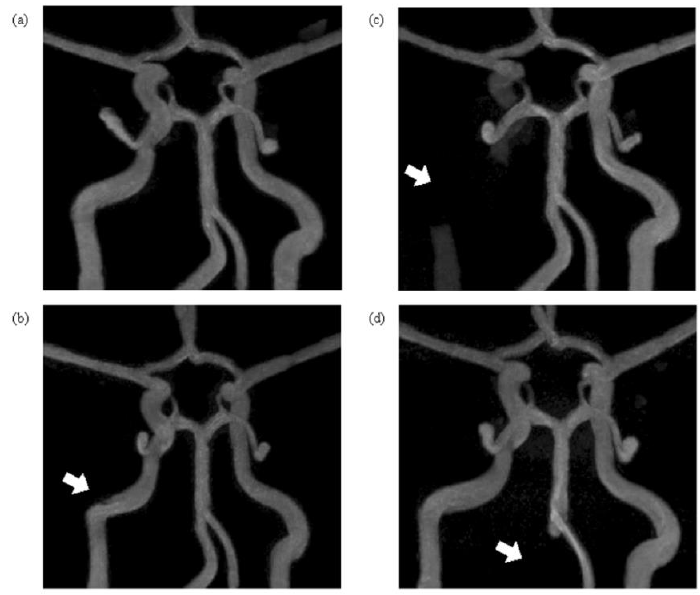
Figure 4. Time-of-flight (TOF) MRA maximum intensity projection (MIP) images of each vascular model: ( a ) normal phantom; ( b ) right ICA 50% stenosis phantom (ICA50); ( c ) right ICA 100% occlusion phantom (ICA100); and ( d ) right vertebral artery (VA) 100% occlusion phantom (VA100). The reconstructed TOF MRA images from each phantom were visualized using maximum intensity projection (MIP) in the coronal plane. The white arrows indicate the regions where cerebrovascular disease was modeled.